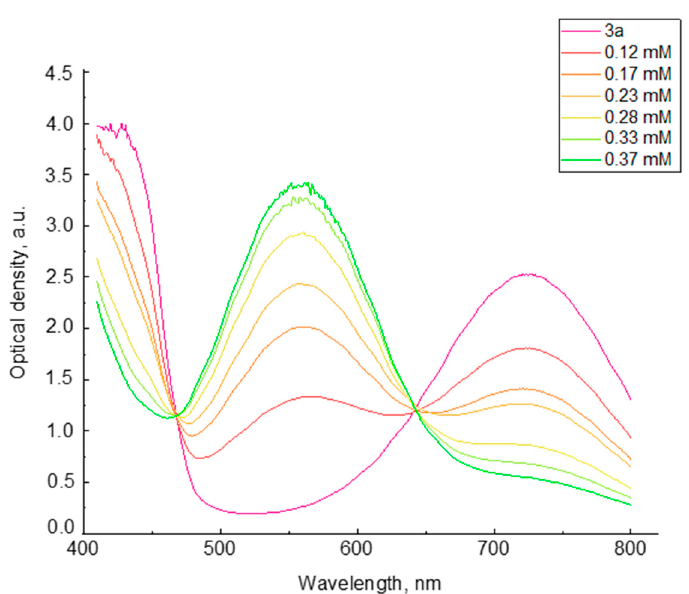
Figure 3. UV-Vis spectra of 3a in different